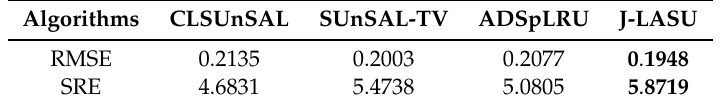
Table 4. RMSE and SRE Comparison Result for Urban data.